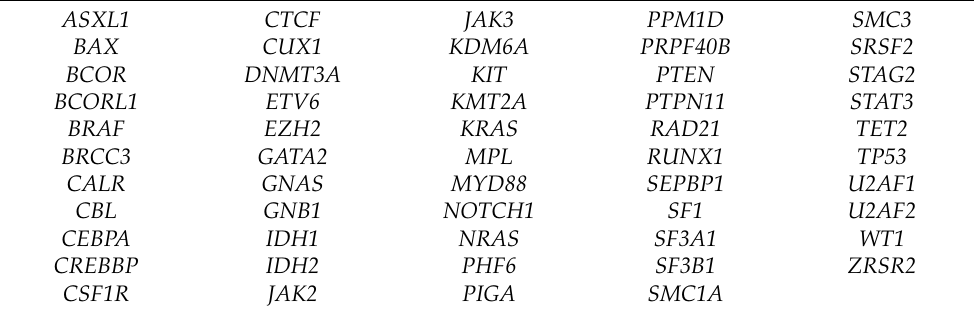
Table 1. Genes recurrently mutated in CHIP